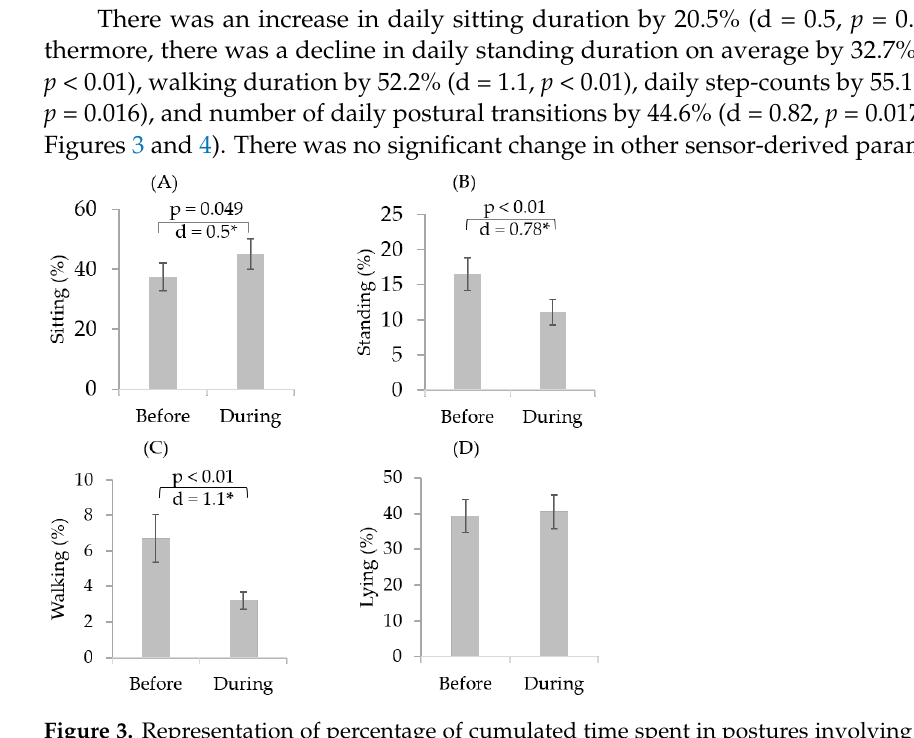
Figure 3. Representation of percentage of cumulated time spent in postures involving ( A ) sitting; ( B ) standing; ( C ) walking; and ( D ) Lying by the participants as remotely assessed by the PAMSys sensor before and during the pandemic. While there was no significant change in overall time spent lying, there was a significant increase in sedentary behavior and a decline in time spent walking or standing. * represents significant difference ( p < 0.05).